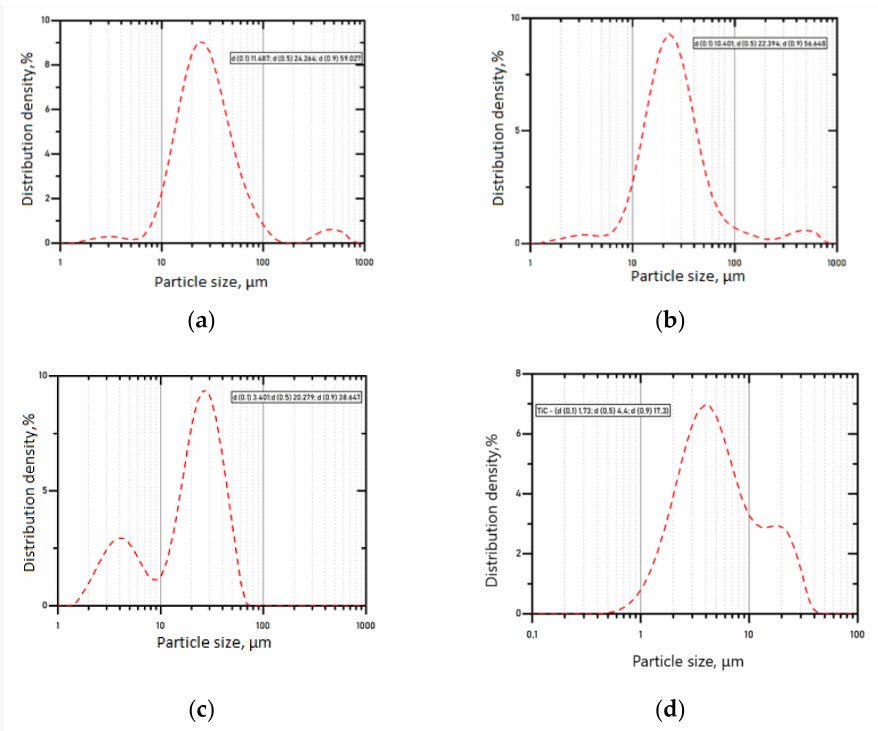
Figure 2. The results of the fractional composition study of the powders: ( a ) nickel; ( b ) copper; ( c ) zinc; ( d )